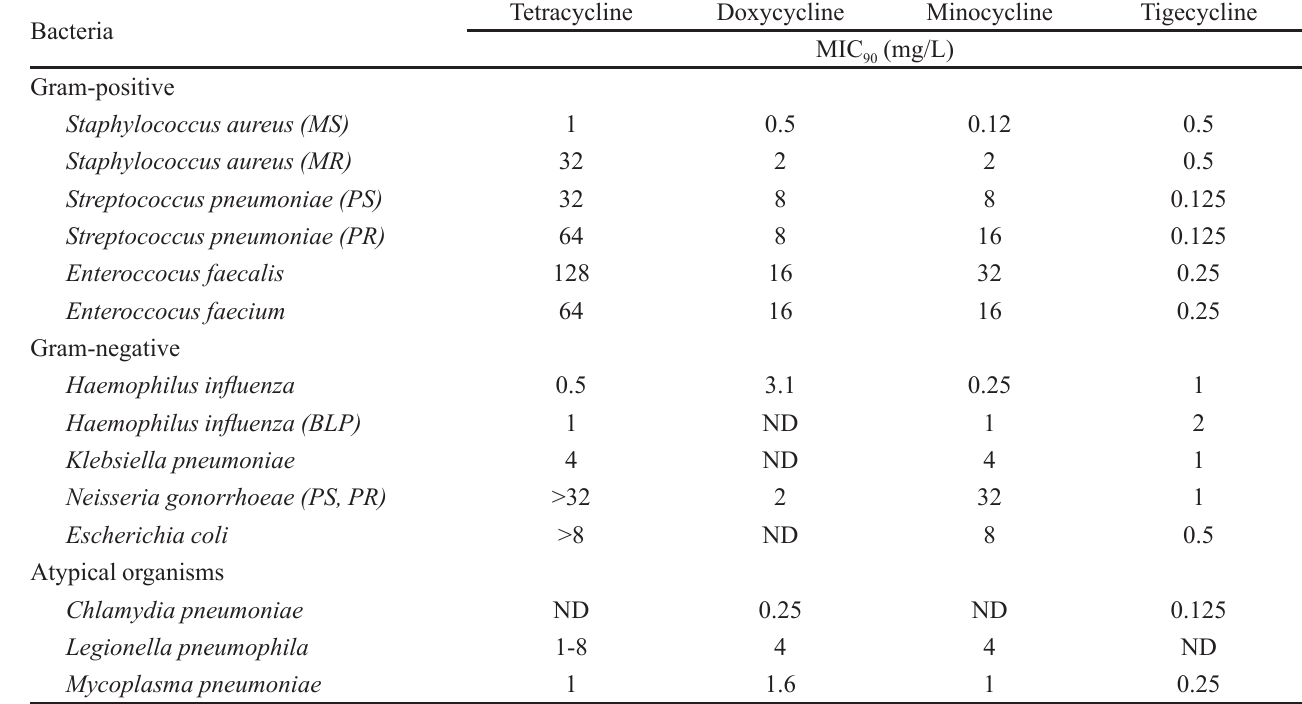
TABLE I - In vitro activity of tetracyclines in selected organisms (Pereira-Maia et al. , 2010)